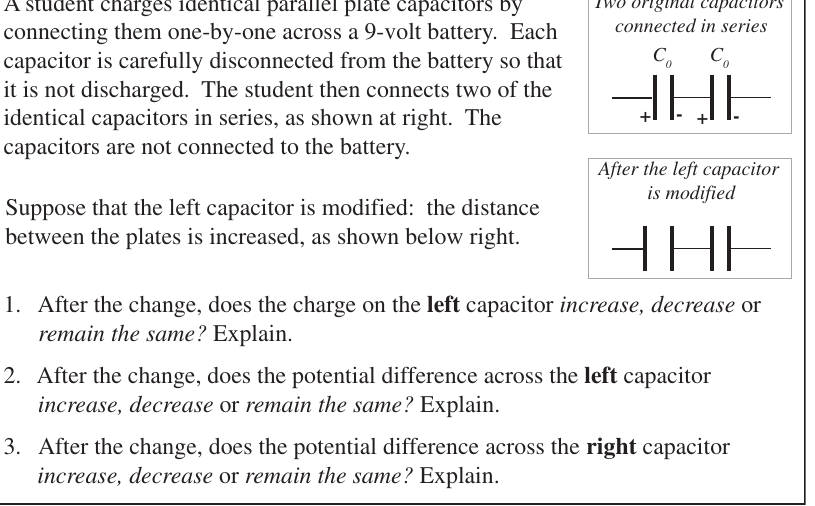
FIG. 2. Sequence of questions: